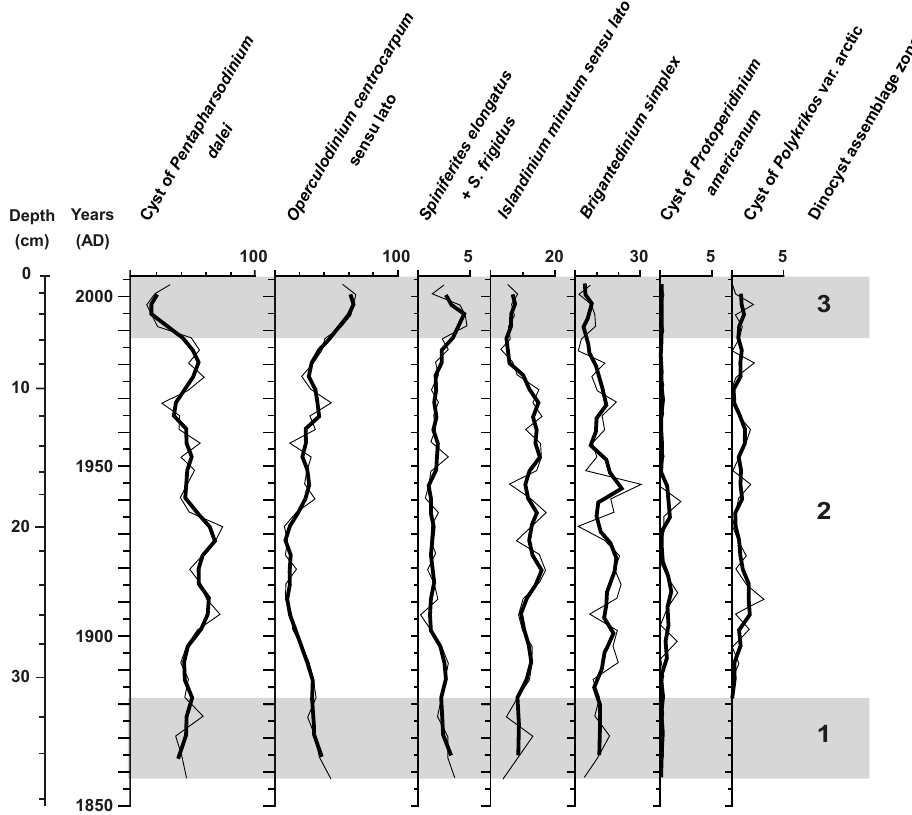
Fig. 5. Relative abundances of the main dinocyst taxa in core MA680BC and dinocyst assemblage zones plotted against depth and age AD. The thick curves represent a running average over 3 data